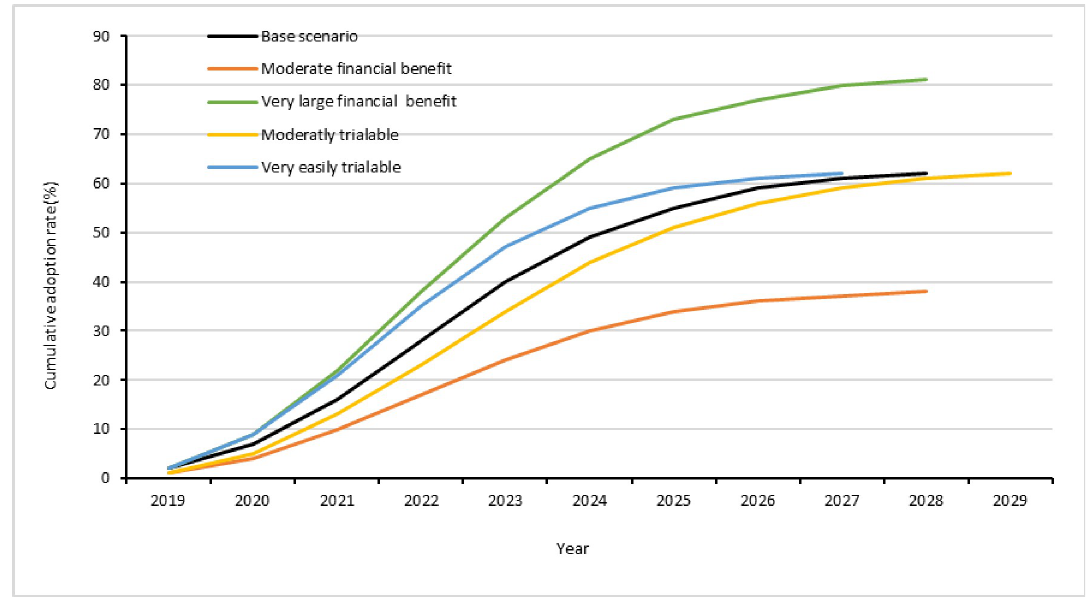
Fig 6. Predicted adoption and its sensitivity to farmers’ perceptions on financial benefit and trialability of the new groundnut plant spacing.